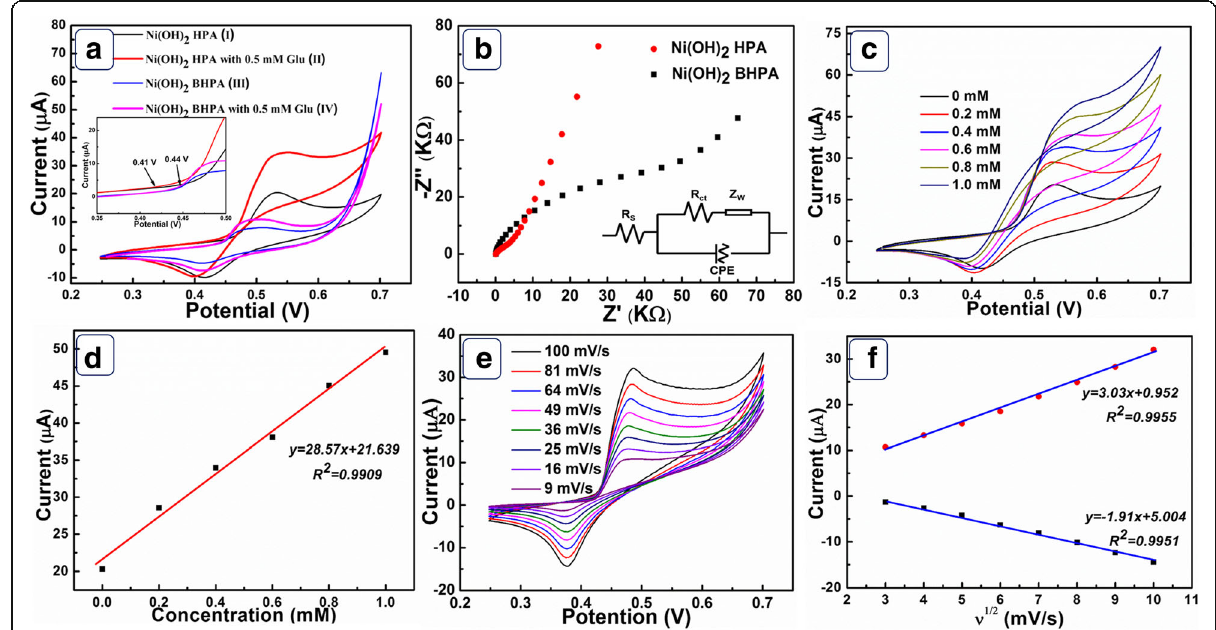
Fig. 4 a CVs of Ni(OH) 2 HPA (I, II) and Ni(OH) 2 BHPA (III, IV) electrodes with (II, IV) and without (I, III) the presence of 0.5 mM glucose at 50 mV/s. b Nyquist diagrams EIS and equivalent circuit of Ni(OH) 2 HPA and Ni(OH) 2 BHPA. c CVs of Ni(OH) 2 HPA electrode at various concentration of